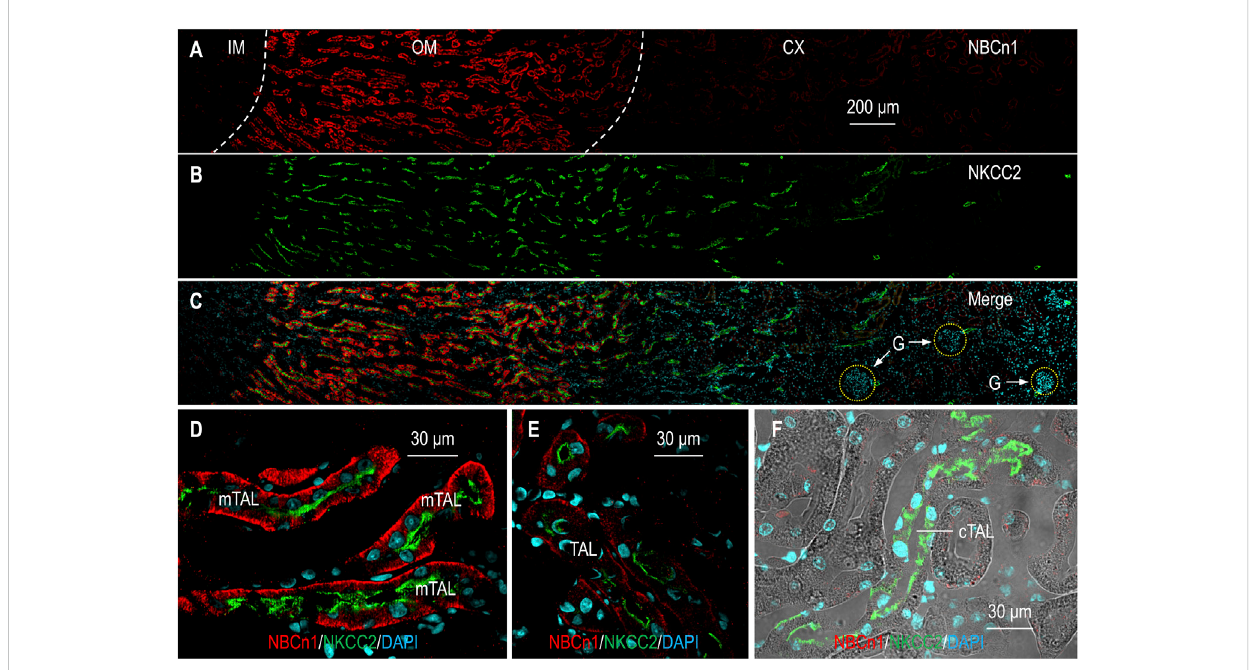
FIGURE 1 Indirectimmuno fl uorescenceofNBCn1inratkidney. (A – C) OverviewofthedoublestainingofNBCn1andNKCC2inaratkidneysection.Toprovide a whole view of the tissue distribution of NBCn1 (red) and NKCC2 (green), the fi gure was generated by overlaying four continuous images acquired from the inner medulla through the cortex. NKCC2 was present along the whole TAL from the OM through the CX. The fl uorescence signal of NBCn1 was strongintheOM,relativelyweakintheOM-CXboundaryregion,andnegligibleintheCX. (D) NBCn1washighlyexpressedinthebasolateraldomain of mTAL. (E) NBCn1 was expressed in relatively lower level in the basolateral domain of the TAL in the OM-CX boundary region. (F) NBCn1 was not detectable in the cortical TAL. IM, inner medulla; OM, outer medulla; CX, cortex; G, glomerulus. The blue indicates nuclei counter-stained by